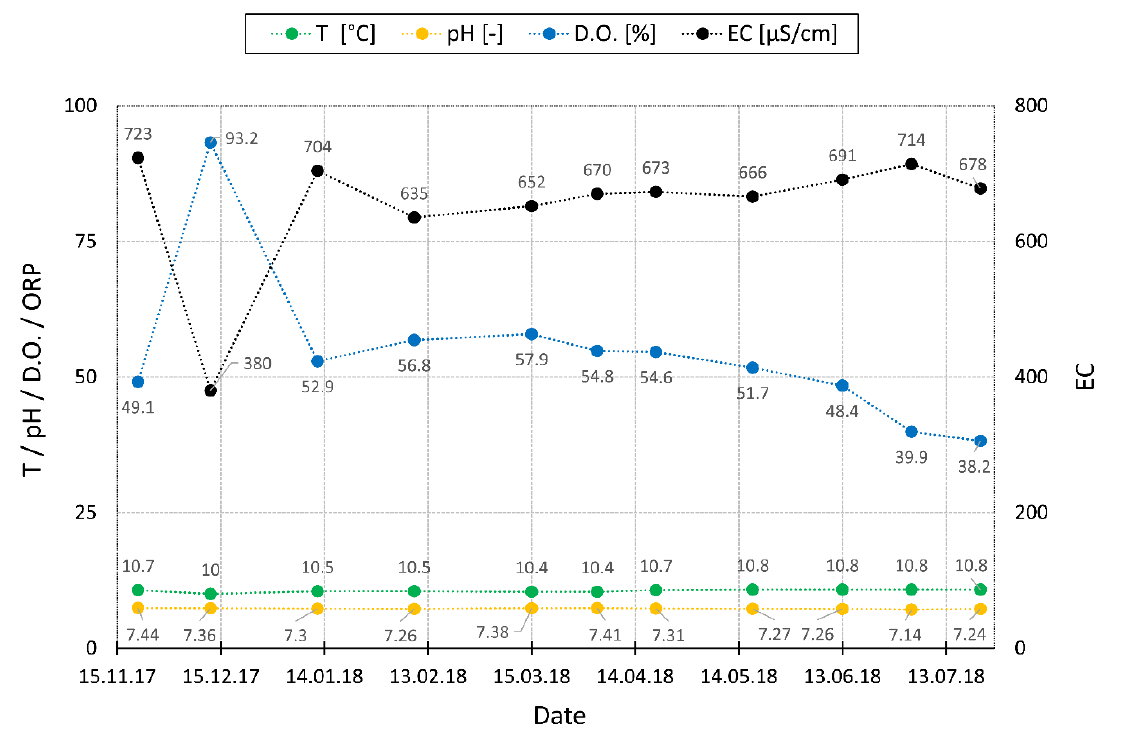
Figure 3. Field measurements of Žvepovnik spring water .